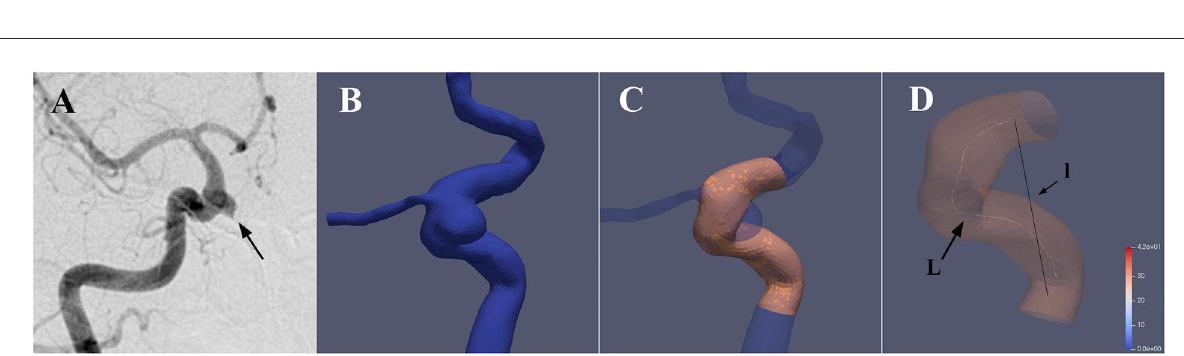
FIGURE2 3D reconstruction of the parent artery and extraction of the vessel centerline. (A) A case with a right carotid ophthalmic aneurysm was treated with a PED stent. (B) The 3D vessel model was extracted from the raw 3D acquisition data using segmentation and surface reconstruction tools. (C) The aneurysm and irrelevant branch vessels were removed to get the idealized 3D reconstruction model of the parent artery, and the stent implantation segment was then identified and segmented. (D) Aneufuse software was used to determine the centerlines of the reconstructed 3D model. The curvature and torsion of each discrete 3D point and distance metric (DM) of the parent artery were then calculated. (l is the straight-line distance and L is the total path